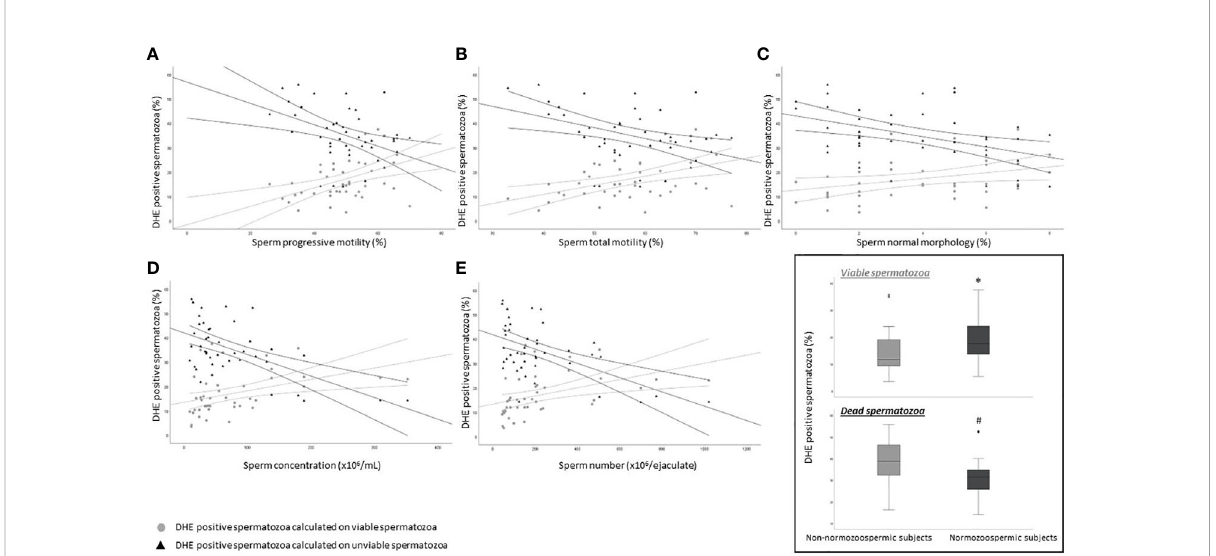
FIGURE 6 Scatter plots representing the relationship between the percentage of DHE viable (grey circles) and unviable (black triangles) positive spermatozoa and progressive ( A , viable: R=0.5, p<0.01; unviable: R=-0.4, p<0.01) and total ( B , viable: R=0.5, p<0.01; unviable: R=-0.4, p<0.01) motility, normal morphology ( C , viable: R=0.4, p<0.05; unviable: R=-0.4, p<0.05), concentration ( D , viable: R=0.5, p<0.01; unviable: R=-0.5, p<0.01) and number ( E , viable: R=0.6, p<0.01; unviable: R=-0.4, p<0.01) in 44 subjects. Inset: box plots of the percentage of DHE viable (upper panel) and unviable (lower panel) positive spermatozoa in Non-normozoospermic (n=24) and Normozoospermic subjects (n=20). *p<0.05 vs. Non-normozoospermic subjects; #p<0.01 vs. Non-normozoospermic